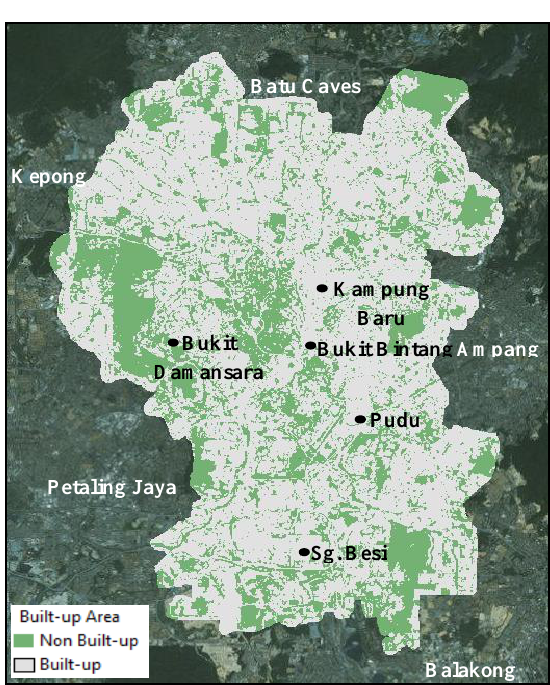
Figure 7. The relationship between LST and the density of built-up area